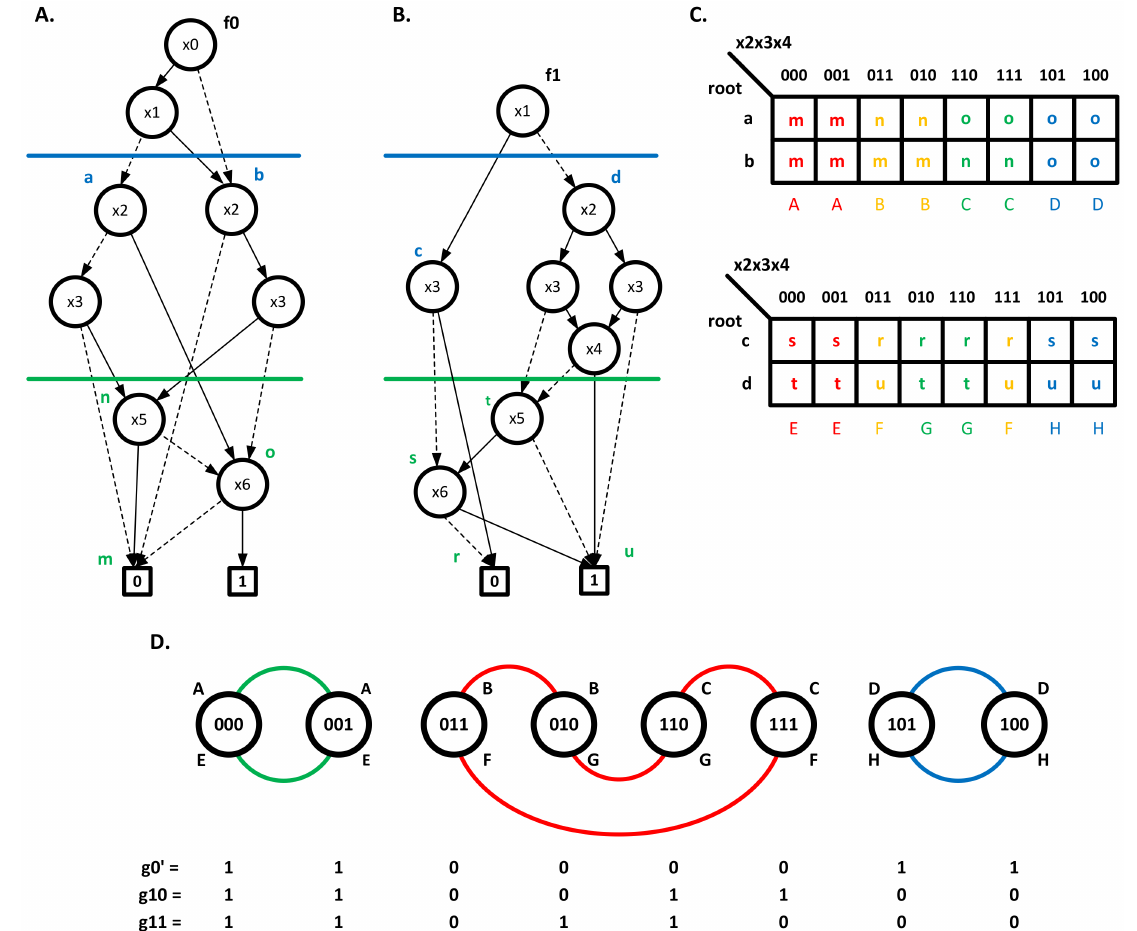
Figure 12. The idea of searching for shared bound functions: input functions f 0 ( A ) and f 1 ( B ), root tables of functions ( C ), identical symbols graph ( D ).